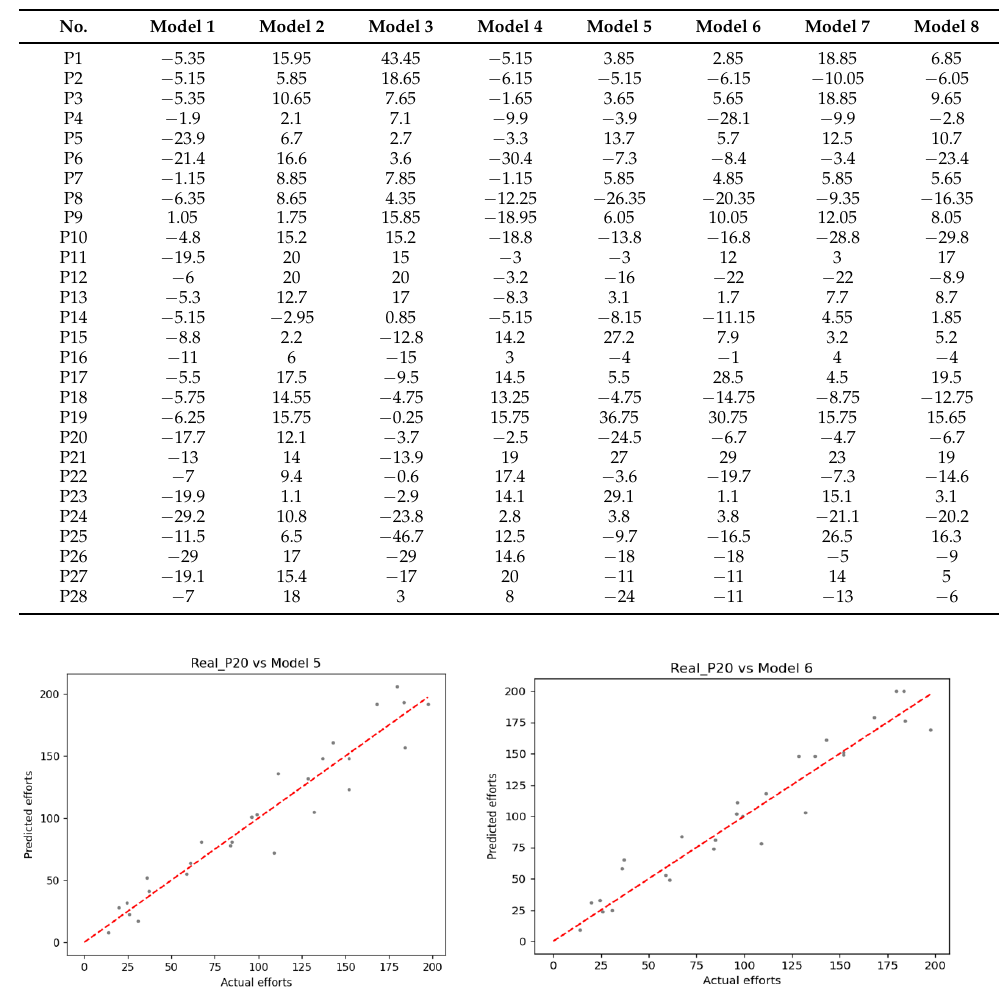
Figure 4. The scatter of predictive efforts vs. actual efforts: Model 5 vs.